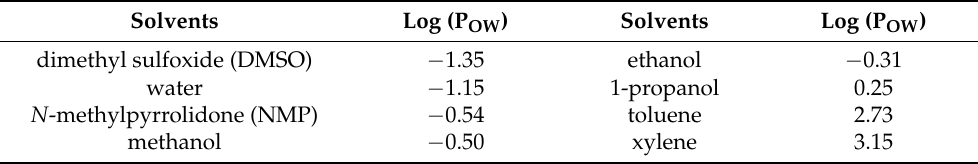
Table 1. Log (octanol/water partition coefficient (P OW )) of several solvents [26]. Solvents Log (P OW ) Solvents Log (P OW ) dimethyl sulfoxide (DMSO) − 1.35 ethanol − 0.31 water − 1.15 1-propanol 0.25